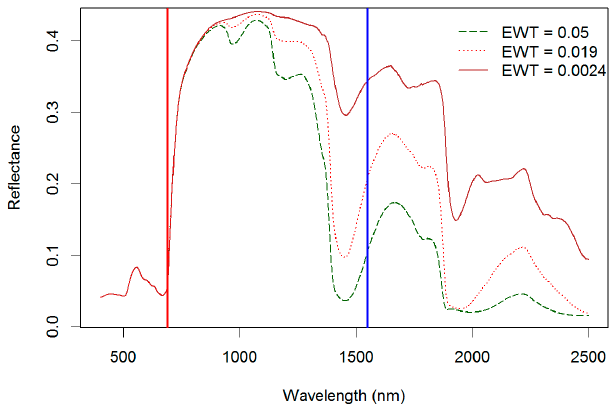
Figure 1. Leaf reflectance spectra between 400 nm and 2500 nm modeled with the PROSPECT-5 model for equivalent water thickness (EWT) ranging between 0.0024 g/cm 2 and 0.05 g/cm 2 . The red and blue bars represent the wavelengths of 690 nm and 1550 nm where the laser scanners were used, respectively.